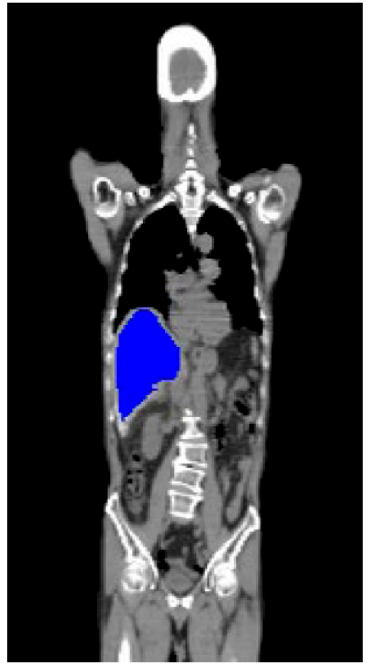
Figure A2. The liver 3D range is marked for training.